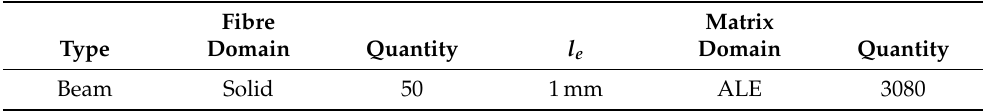
Table 8. Numerical setup for the rheological FSI